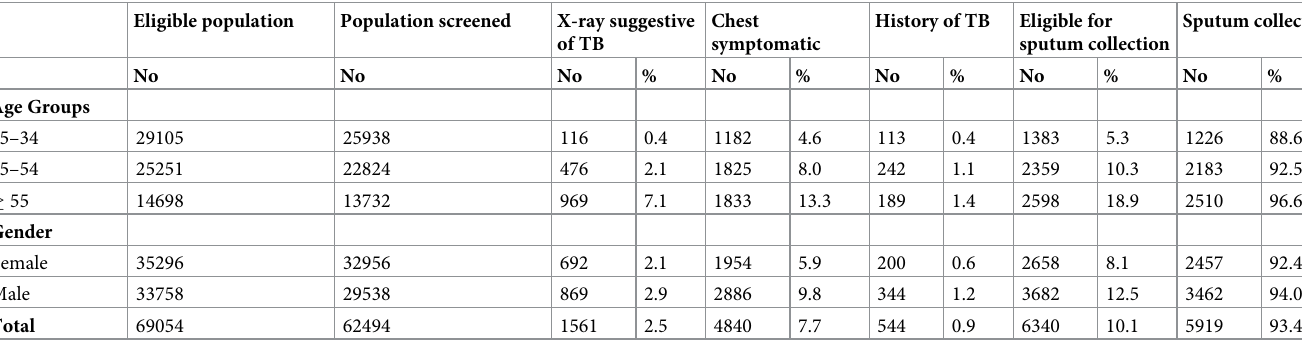
Table 1. Study population and coverage for the prevalence survey. Eligible